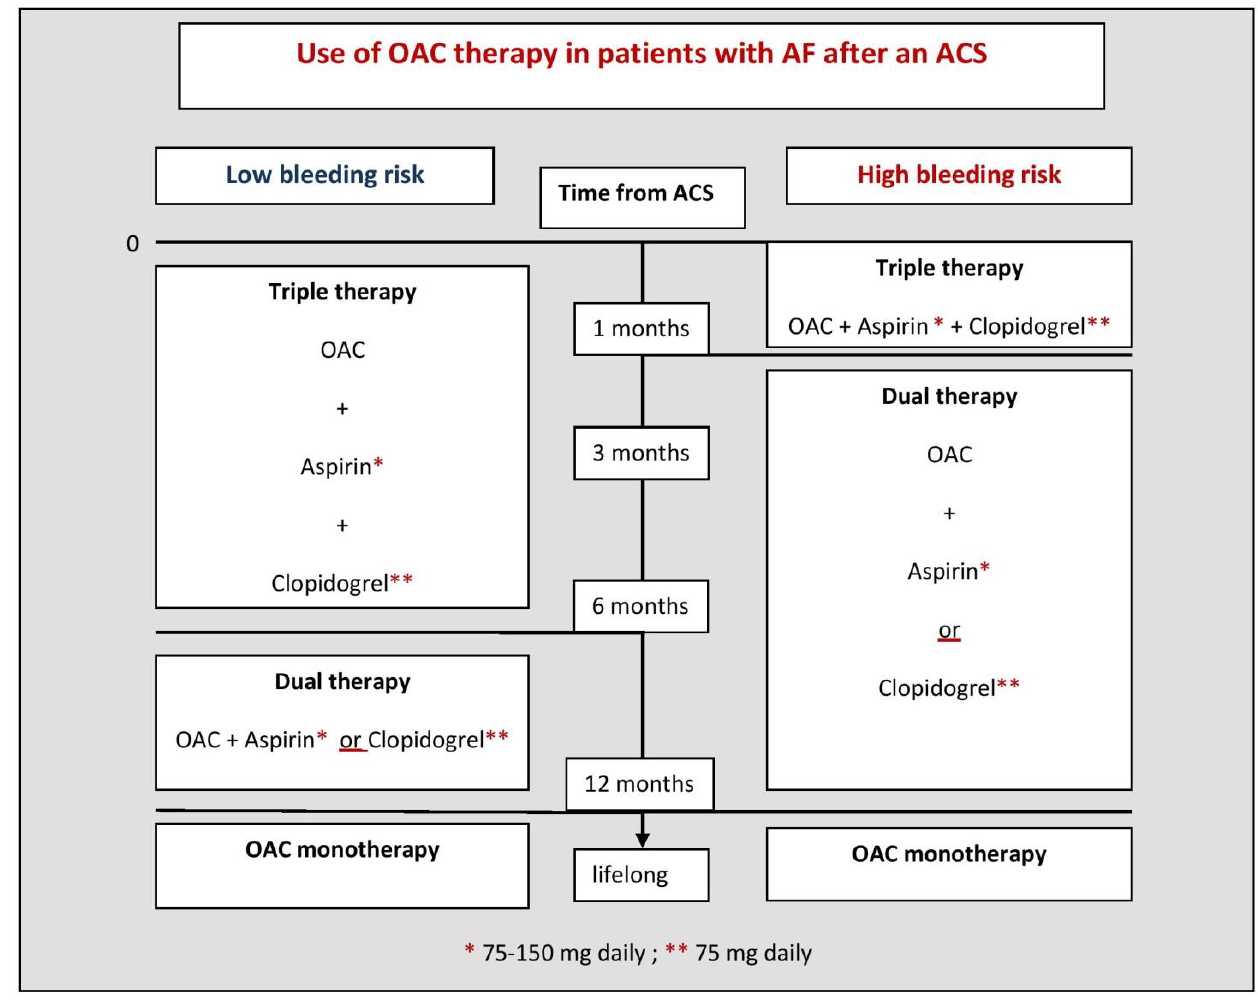
Figure 2. Use of OAC therapy in patients with AF after an ACS [57]. Legend: * Aspirin dose 75 – 150 mg daily; ** Clopidogrel dose 75 mg daily; ACS — acute coronary syndrome; AF — atrial fibrillation; OAC — oral anticoagulation (using vitamin K antagonist or non-vitamin K antagonist oral antico- agulants).